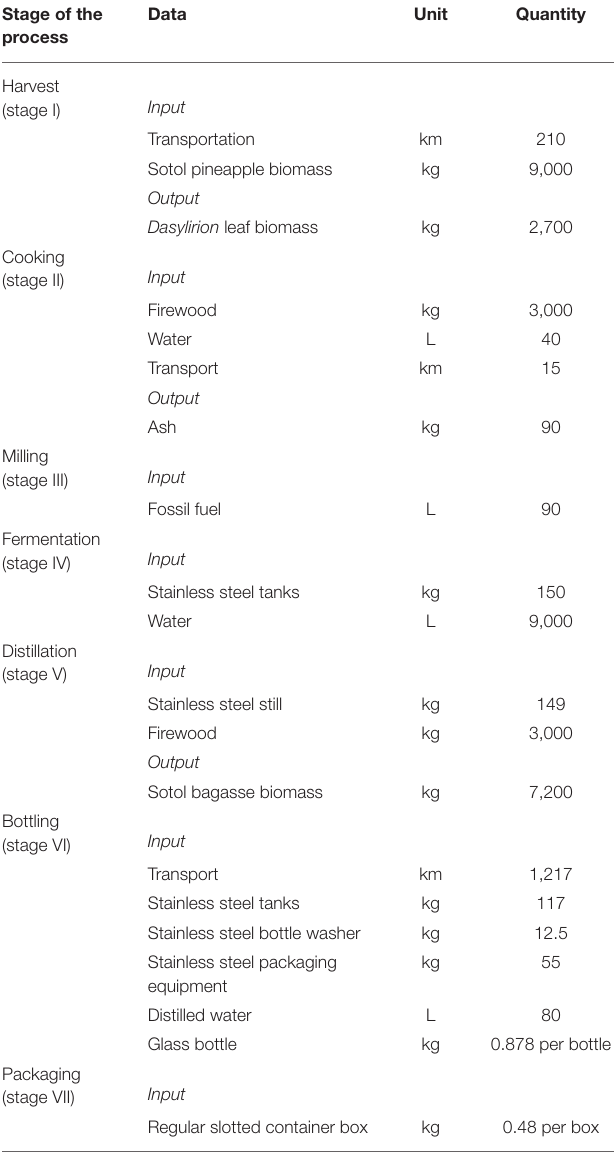
TABLE 2 | Empirical data for life cycle inventory. Stage of the